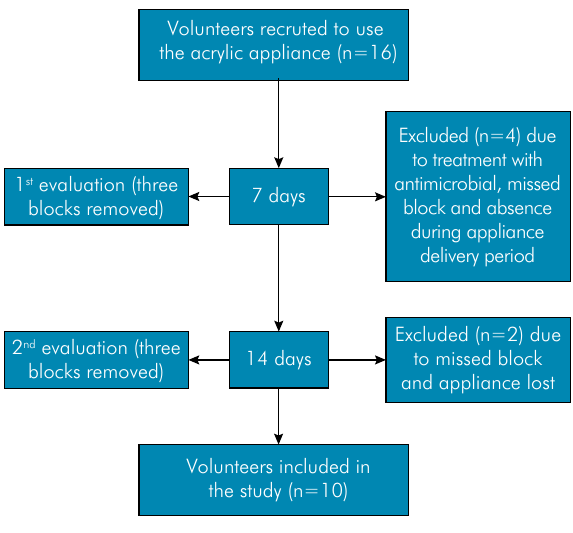
Figure 1. Flowchart of volunteers included/excluded in the in situ